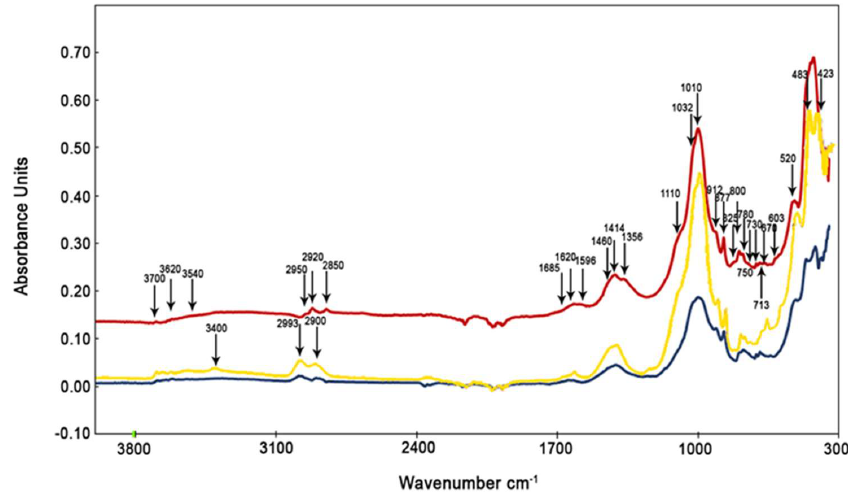
Figure 4. FTIR spectra of urban PM 10 (GC, yellow line) and PM 2.5 (DB, red line) filters. Blue line is FTIR spectrum of Saharan dust deposited in Palermo.